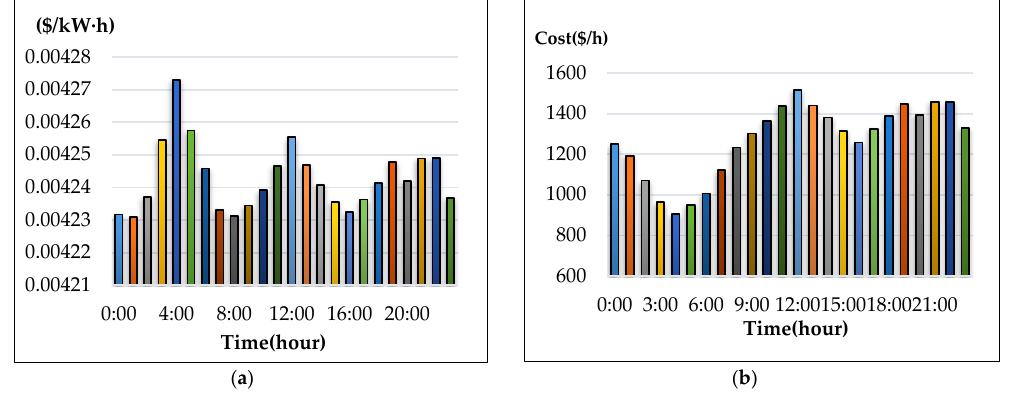
Figure 11. Numerical results of the generation cost per kWh and total generation cost. ( a ) generation cost per kW-hour; ( b ) total generation cost.